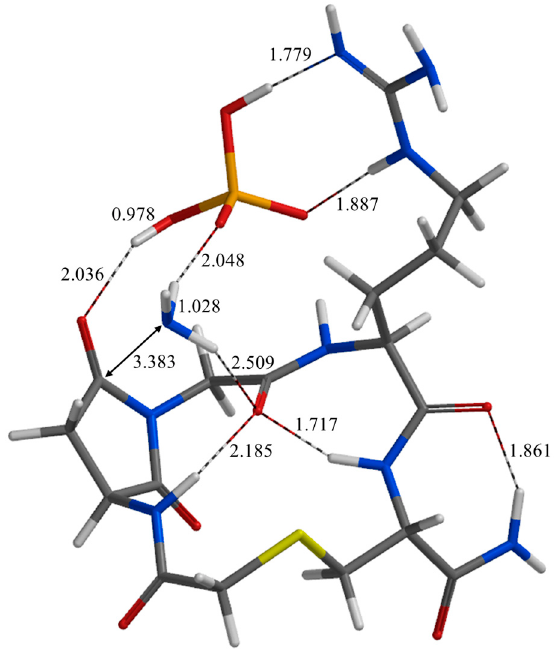
Figure 13. The geometry of PC (product complex). Selected interatomic distances are shown in Å. Grey: carbon; white: hydrogen; blue: nitrogen; red: oxygen; orange: phosphorus; yellow: sulfur.